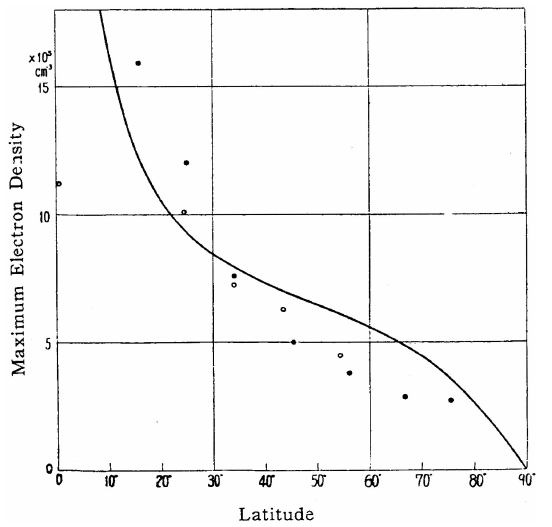
Figure 10. Calculated ray paths of VLF waves (solid curves) and geomagnetic field lines (dashed curves) (Maeda and Kimura, 1956).